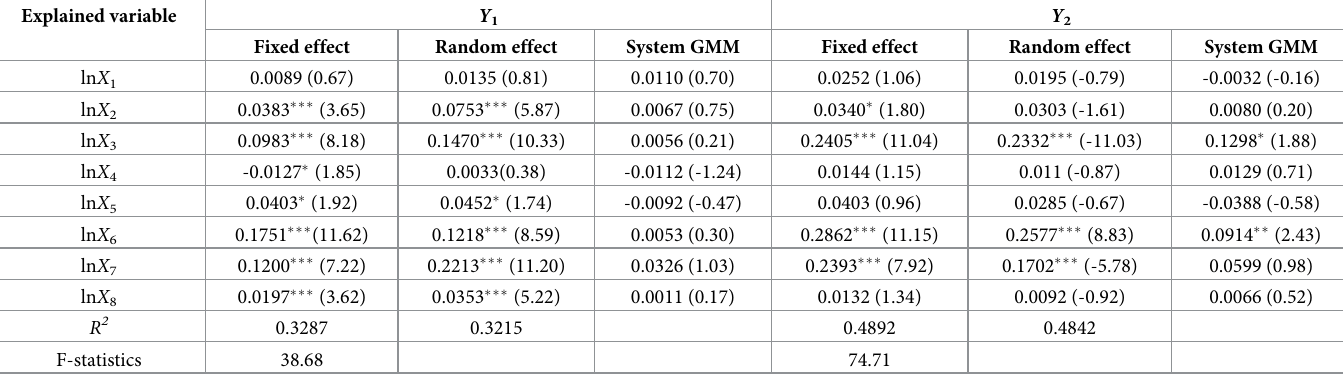
Table 6. Panel regression results of factors affecting urban shrinkage in the Yellow River Basin. Explained